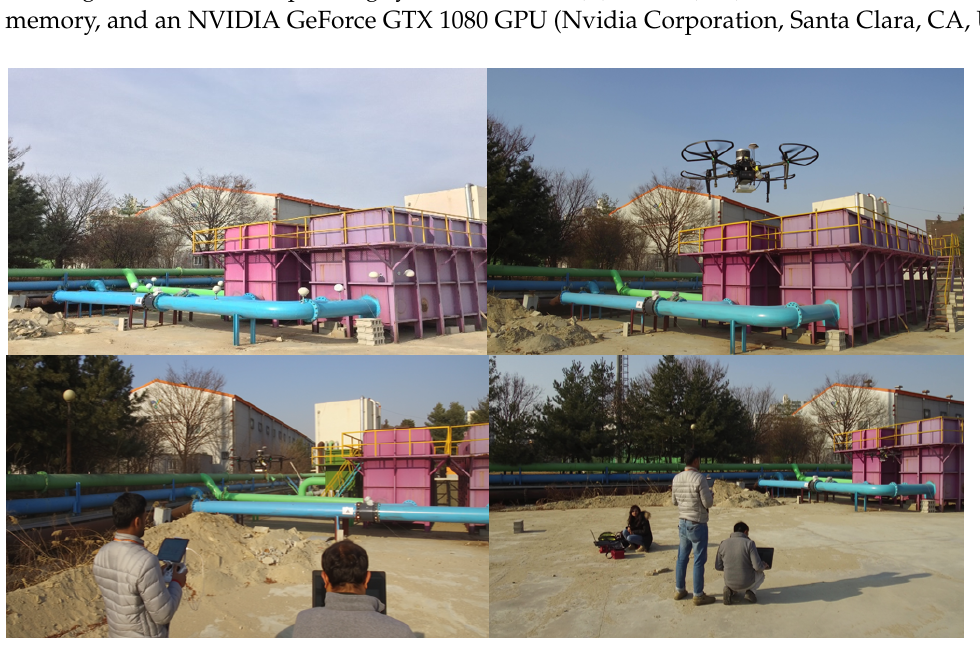
Figure 15. Experimental setup at on-site water treatment